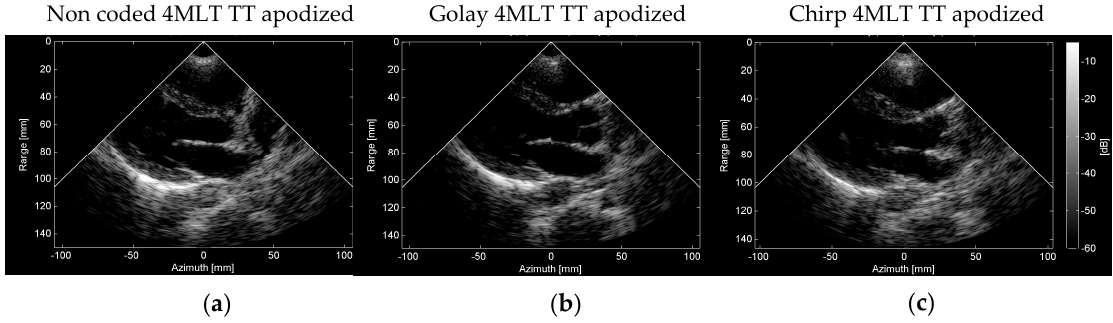
Figure 13. In-vivo examples of 4MLT schemes using ( a ) non-coded excitation, ( b ) Golay coded excitation, and ( c ) chirp coded excitation with TT apodization. TT: Tukey ( α = 0.5)-Tukey ( α = 0.5) apodization scheme. Video clips available online. A dynamic range of 55 dB was used (video clips available as supplementary materials).